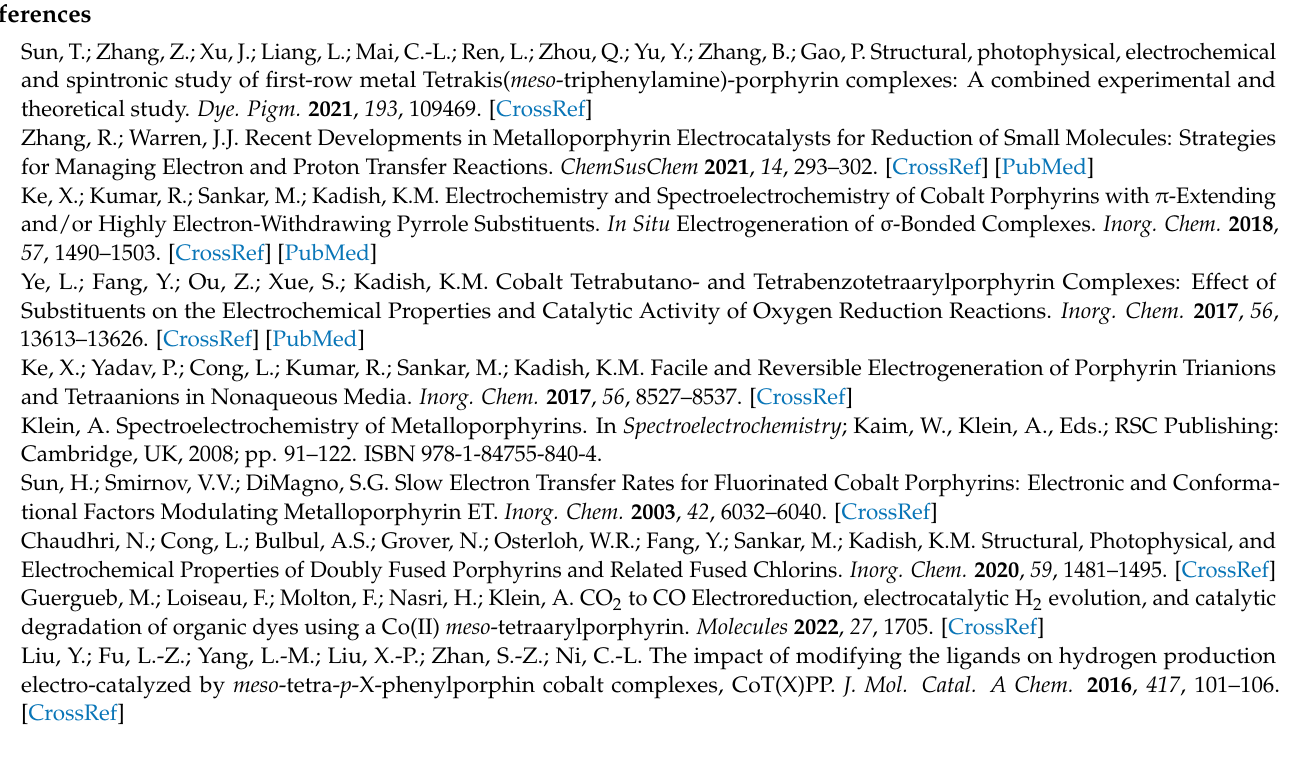
against 1/ v . Figure S10: UV-vis absorption spectra of an aliquot of the solution of [Co(TTMPP)] in DMF before and after a controlled-potential electrolysis, with 1 eq. PhOH or with 1 eq. TFE. Figure S11: A: Evolution of the absorbance of MB over time in H 2 O at pH = 7 and 25 ◦ C; 0.024 mmol [Co(TTMPP)], C dye = 0.05 mmol, C H2O2 = 0.06 mmol and changes in ln( C t / C 0 ) over time for both dyes. Figure S12: Consecutive runs in the photocatalytic of 0.05 mmol RhB or MB in the presence of 0.024 mmol [Co(TTMPP)] in H 2 O at pH = 7 and in the presence 0.06 mmol of H 2 O 2